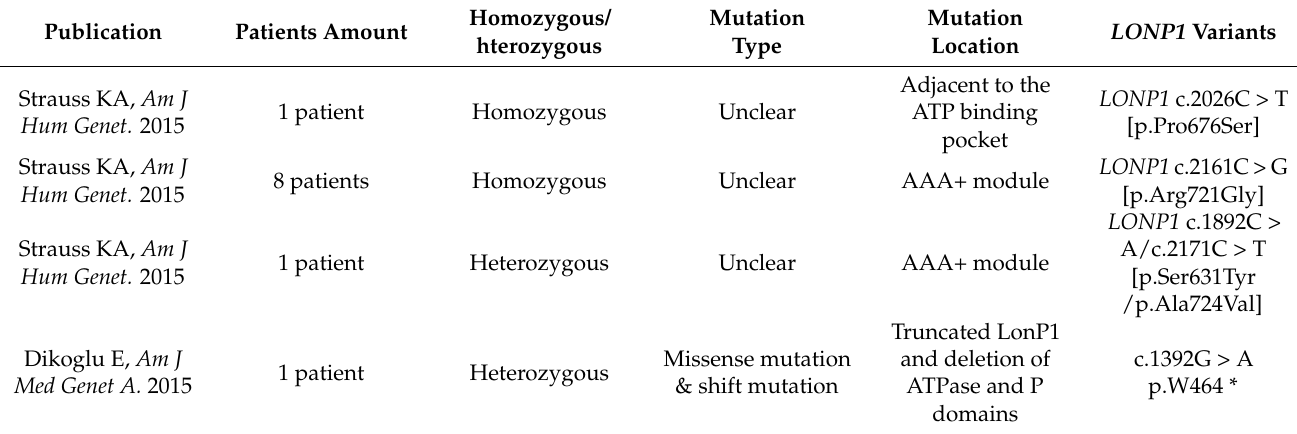
Table 1. Mutation details of the LONP1 gene in CODAS patients with dental